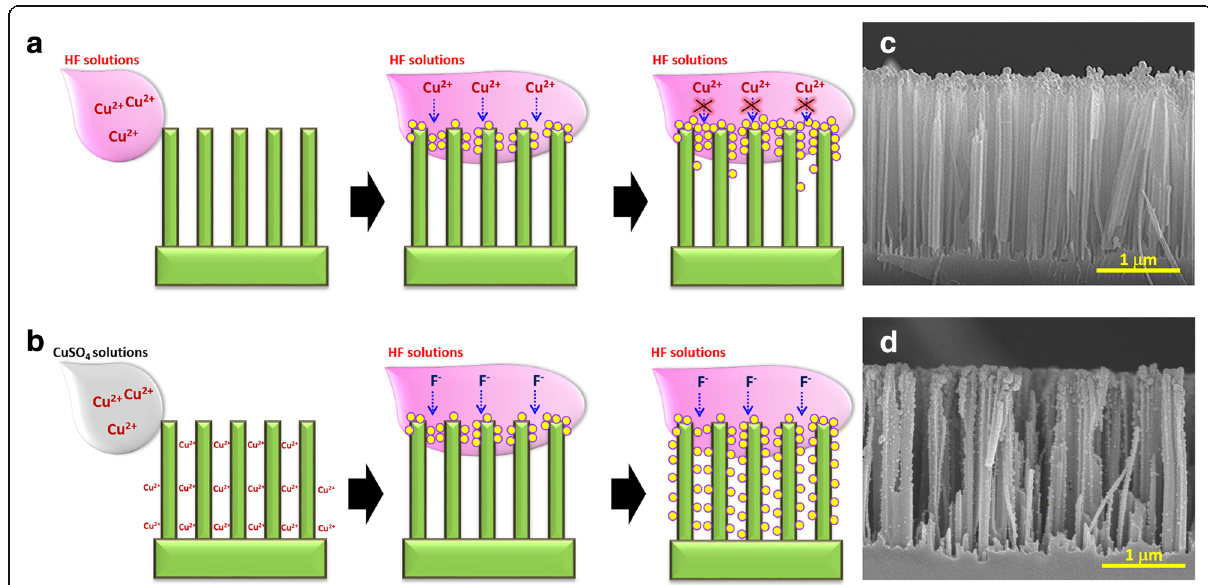
Fig. 1 Schematic illustrations for the formation of a aggregated Cu 2 O and b dispersed Cu 2 O decorated Si nanowires. c , d The SEM images of aggregated Cu 2 O/SiNW arrays (A-Cu 2 O/SiNWs) and dispersed Cu 2 O/SiNW arrays (D-Cu 2 O/SiNWs),